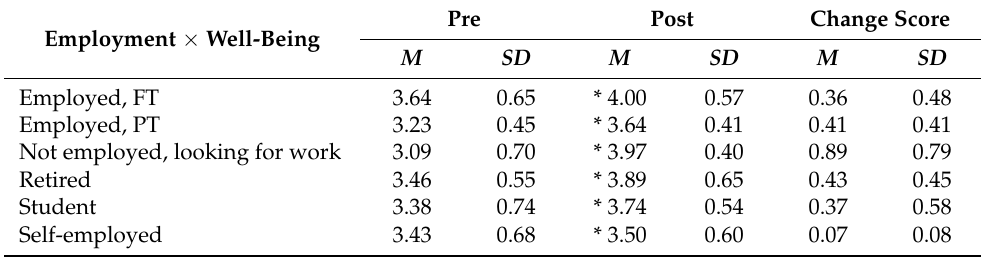
Table 4. Pre-post and change scores for interaction effect of employment x well-being (N =